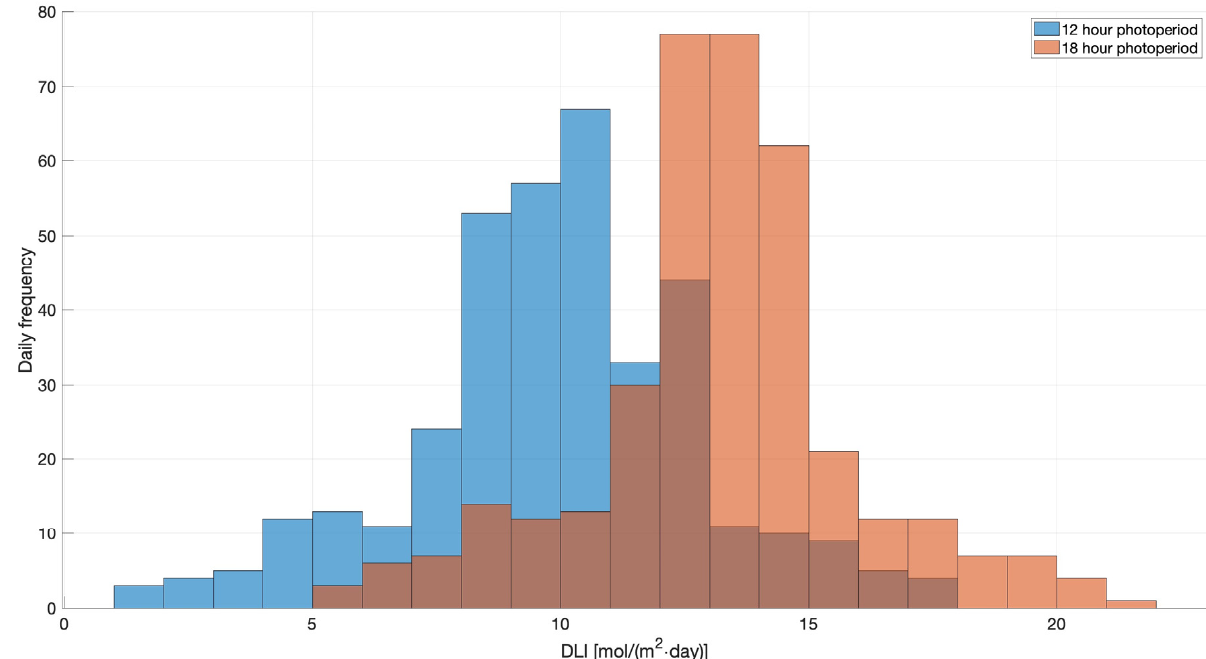
Figure 15. Annual histogram of the calculated DLI for each day of the year for the minimum and maximum proposed photoperiods.